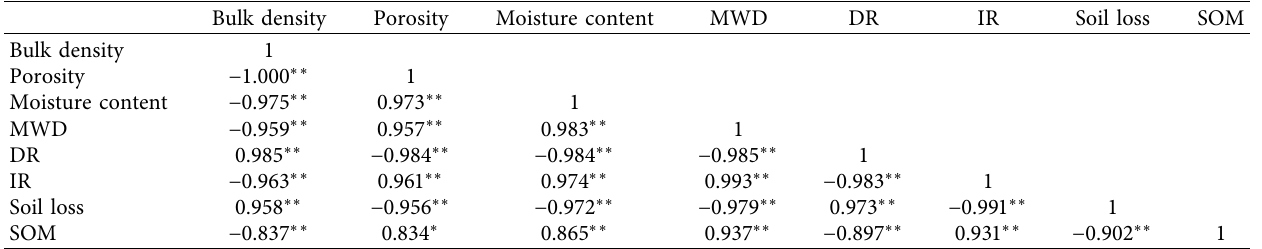
Table 4: Correlation coefficient between soil